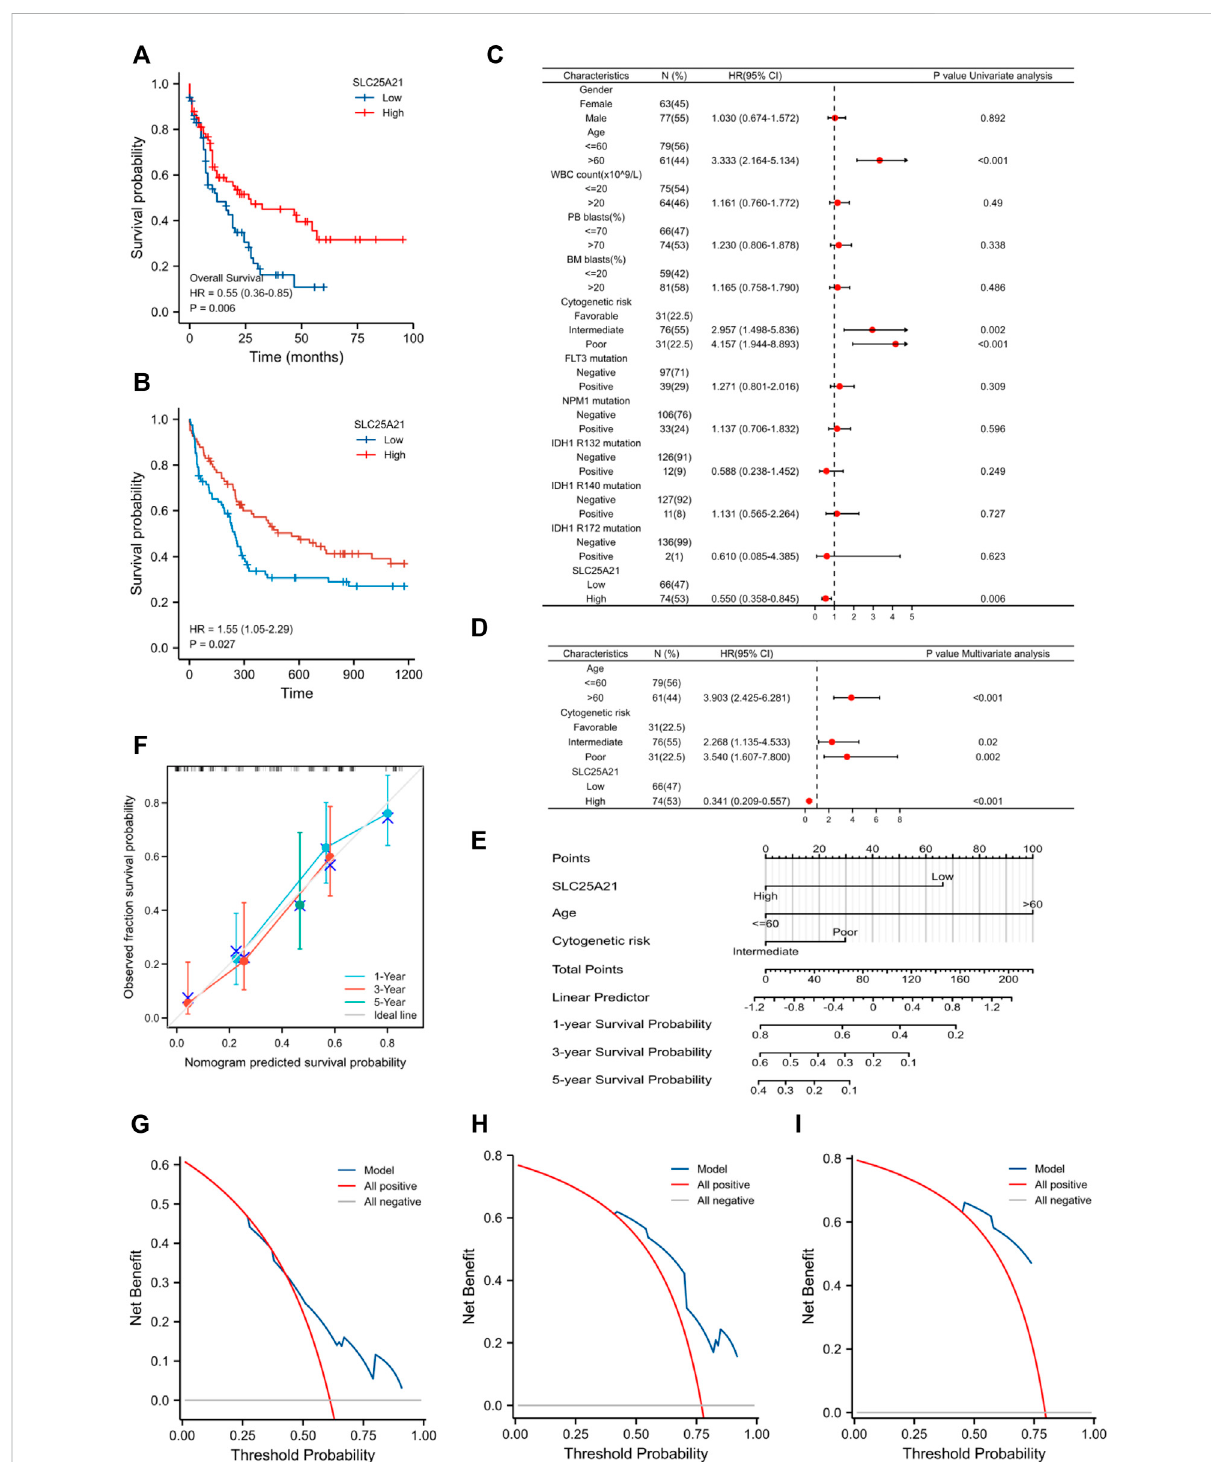
FIGURE 3 The prognostic value of SLC25A21 in AML. (A) Kaplan-Meier curve analysis of overall survival (OS) between the high- and low- SLC25A21 expression groups in the TCGA-LAML dataset. (B) OS analysis of SLC25A21 in the independent validation cohort GSE12417. (C) Univariate analyses of OS shown as a by forest plot. (D) Multivariate analyses of OS shown as a forest plot. (E) A nomogram integrating SLC25A21 and other prognostic factors for AML (mut: mutation, wt, wild type; Int, Intermediate; Fav, Favourable). (F) The calibration curve of the nomogram. The DCA curves of the nomogram at 1 year (G) , 3 years (H) , and 5 years (I)